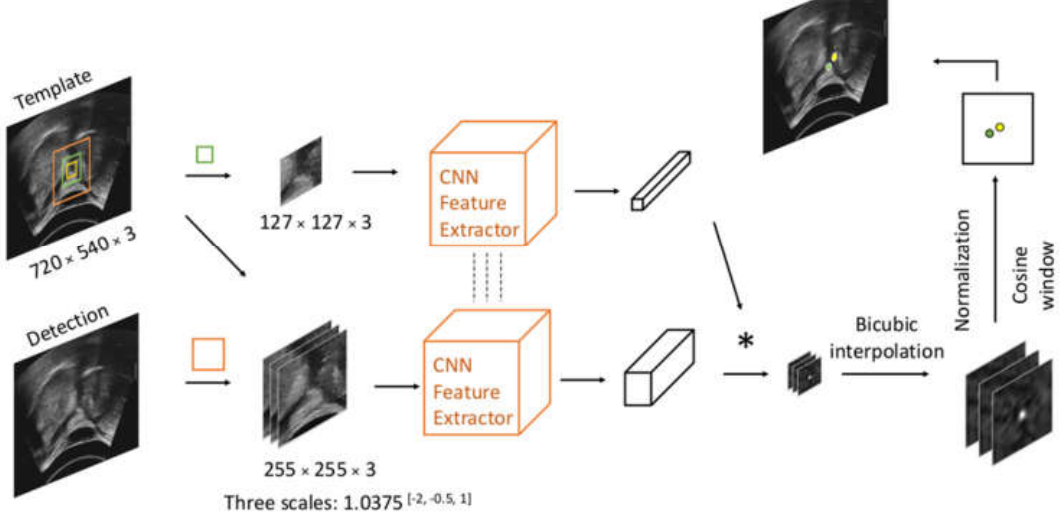
Figure 2. Workflow of Siamese trackers. The center of the yellow bounding box indicates the hyoid location in the last frame; the green box and orange box centered on the last frame hyoid location will crop exemplar patch and search patch on the previous frame and current frame, respectively. The green point indicates the peak response on the score map, while the yellow one denotes the center location of the current frame.